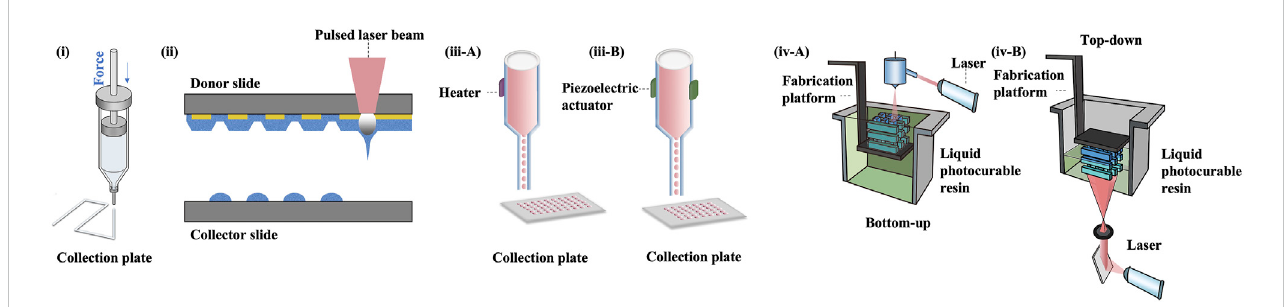
FIGURE 4 3D bioprinting technologies. (i) extrusion bioprinting, (ii) laser-assisted bioprinting, (iii A-B) inkjet bioprinting, (iv A-B) SLA and DLP